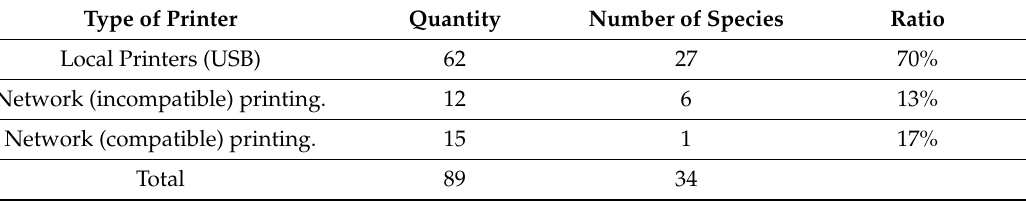
Table 4. Proportion of suitable printers for use with the new system. Type of Printer Quantity Ratio Local Printers